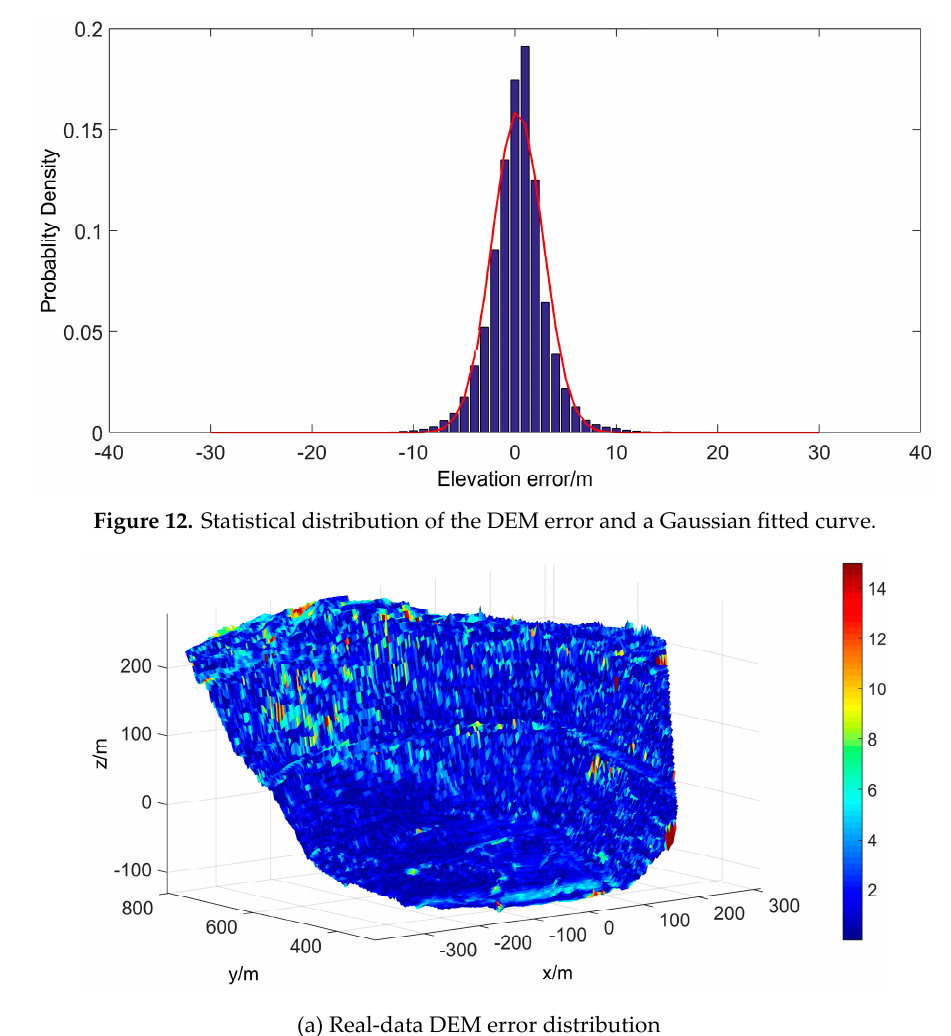
(b) Theoretical DEM error distribution Figure 13. Real-data and theoretical spatial distribution of the DEM error. In fact, the data error is acquired by comparing the InSAR–DEM to the LiDAR–DEM. The error introduced by data processing and data registration also influence the final error, but the theoretical